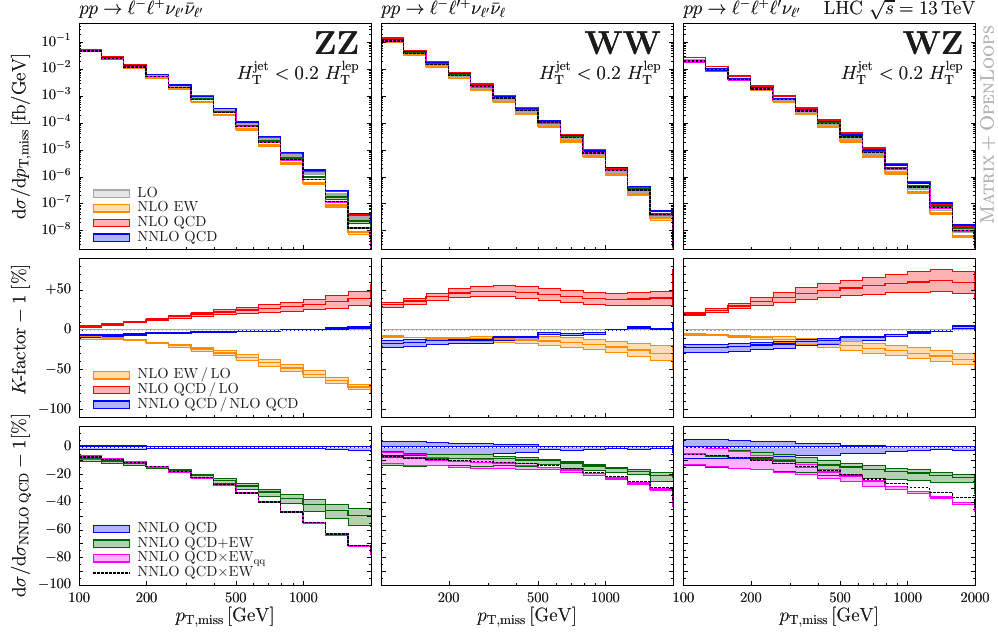
Figure 15 . Distribution in the missing transverse momentum for the processes (3.1){(3.3) at 13 TeV. Same plots as in (cid:12)gure 10, but in addition to the baseline cuts also the jet veto (3.16) is applied.